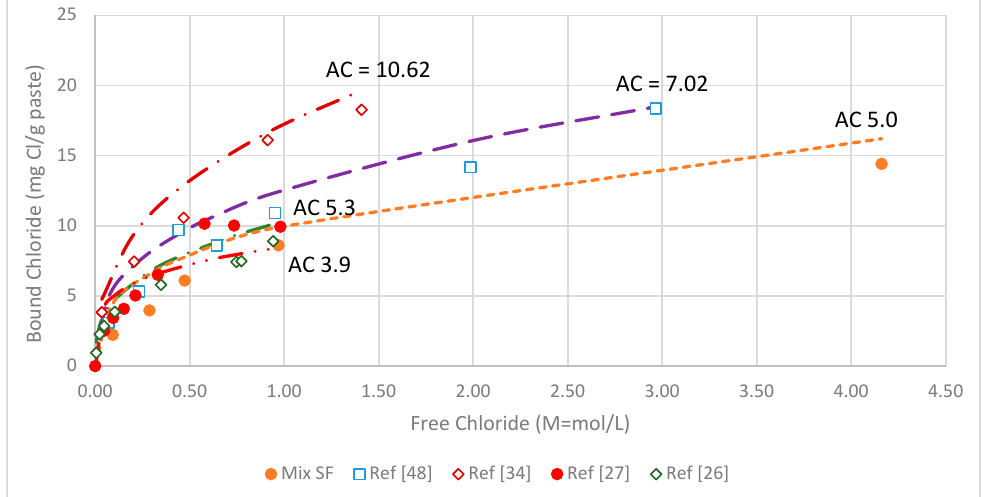
Figure 18. Validation of the proposed model against the experimental cases.